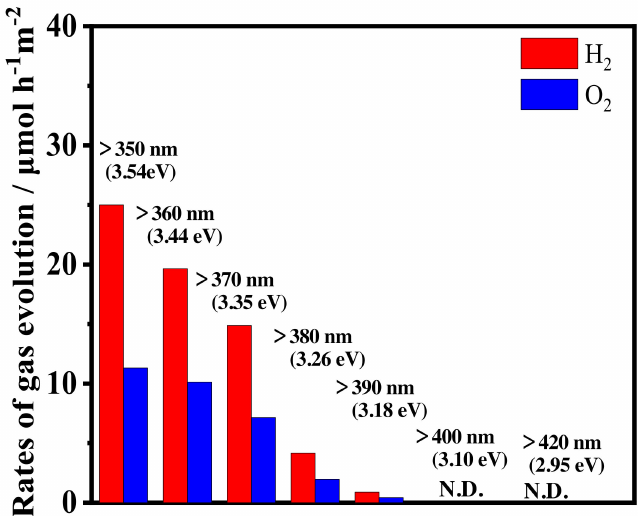
Figure 6. Excitation wavelength dependence of photocatalytic H 2 and O 2 evolution on RuO 2 -loaded 1573K-SSR by using cut-off filters.